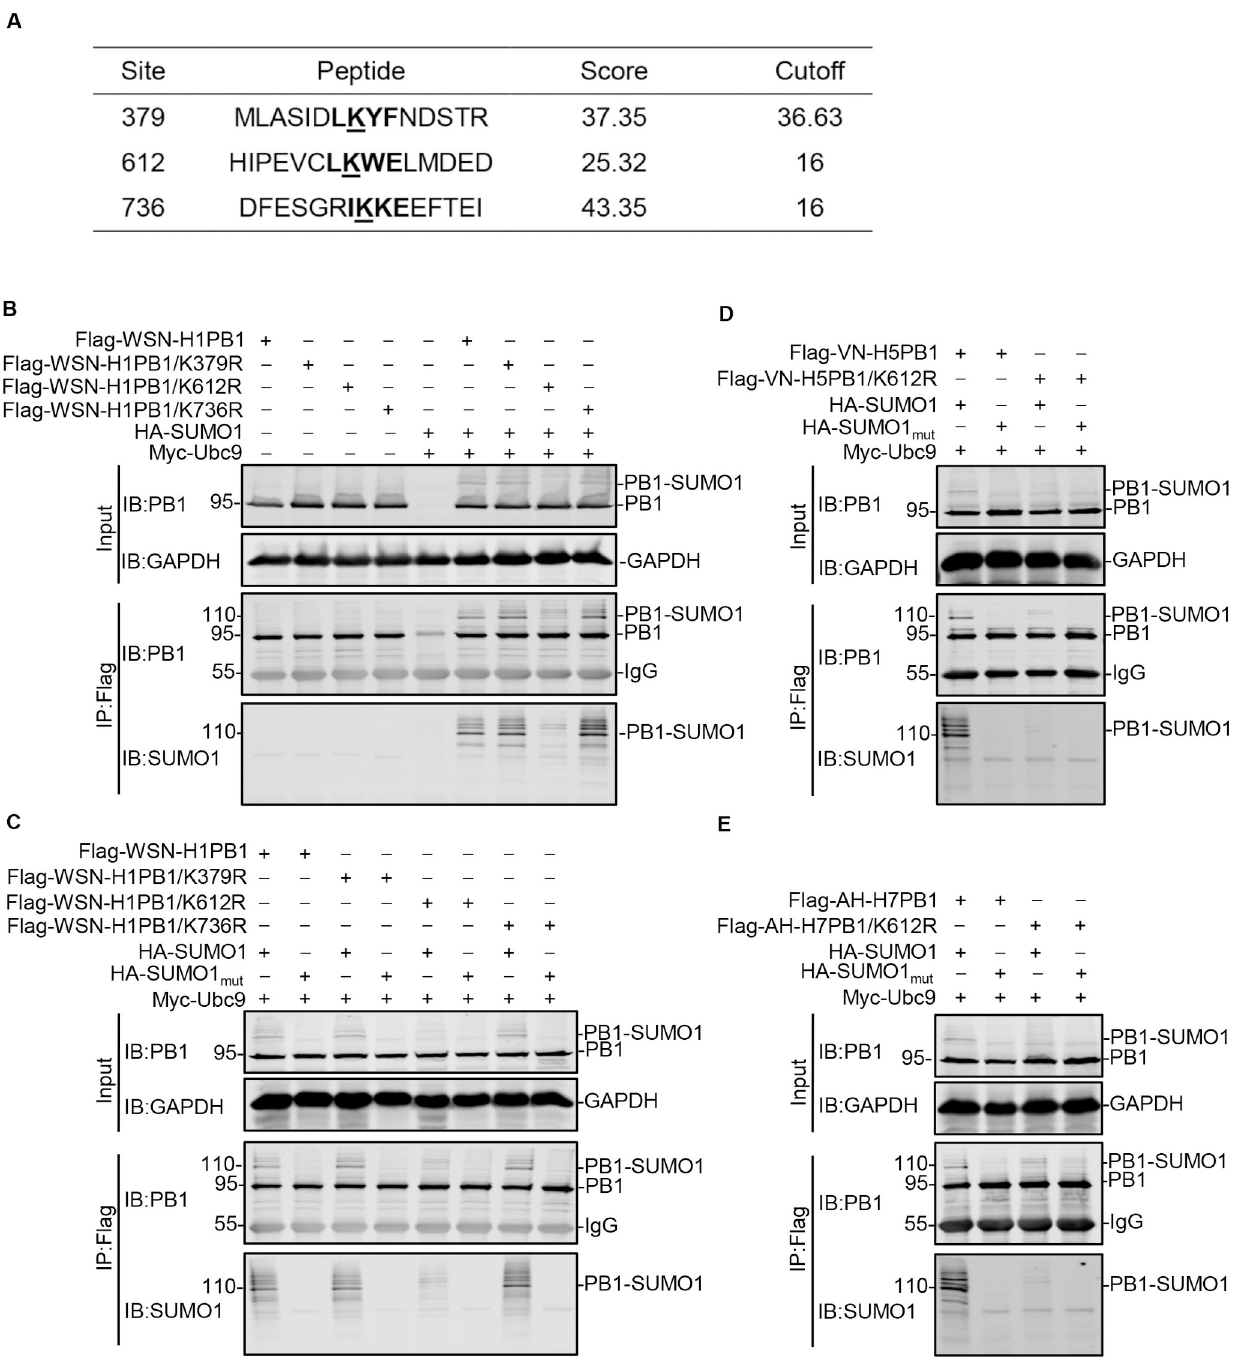
Fig 2. K612 is the key SUMOylation site of IAV PB1. (A) Candidate SUMOylated sites (indicated in boldface and underline) in IAV PB1 were predicted by using the GPS-SUMO software. (B) HEK293T cells were transfected with plasmids encoding Flag-tagged WSN-H1PB1 or its potential SUMOylation site mutant WSN-H1PB1/K379R, WSN-H1PB1/K612R, or WSN-H1PB1/K736R, together with or without SUMO1 and Ubc9. Forty-eight hours later, cell lysates were prepared, immunoprecipitated with anti-Flag M2 agarose beads, and western blotted with an anti-PB1 or anti-SUMO1 mAb. (C) HEK293T cells were transfected with plasmids encoding Flag-tagged WSN-H1PB1 or the indicated potential SUMOylation site mutant, together with SUMO1 or SUMO1 mut , and Ubc9. Immunoprecipitation (IP) and western blotting were performed as in (B). (D, E) HEK293T cells were transfected with plasmids encoding Flag-tagged VN/1180-H5PB1 (D) or AH/1-H7PB1 (E), or their corresponding K612R mutant, together with SUMO1 or SUMO1 mut , and Ubc9. IP and western blotting were performed as in (B). Data shown are representative of three independent experiments in (B-E).